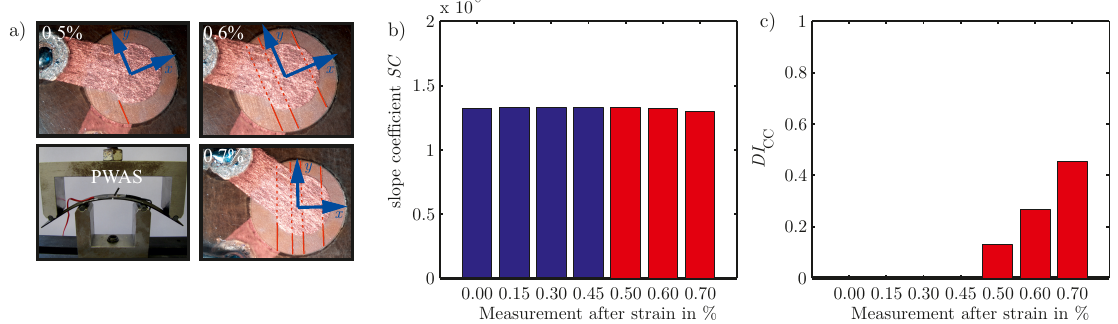
Figure 10. ( a ) Experimental setup and micrographs of the damage states of an embedded PWAS, type DuraAct, see [34], cracks caused by bending in a four-point bending test; ( b ) Calculated slope coefficient SC for measurements at different damage states; ( c ) Calculated damage indicator DI CC for measurements at different damage states. The bars are marked blue for the undamaged and red for the damaged